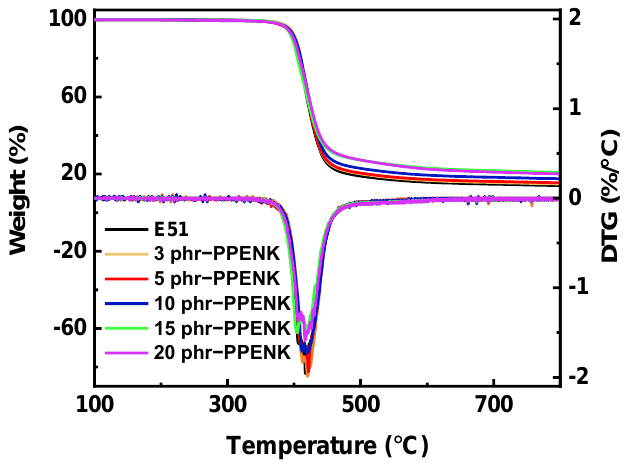
Figure 11. TGA curves of PPENK/E51 blends. Table 4. Thermal stability date of PPENK/E51 blends.